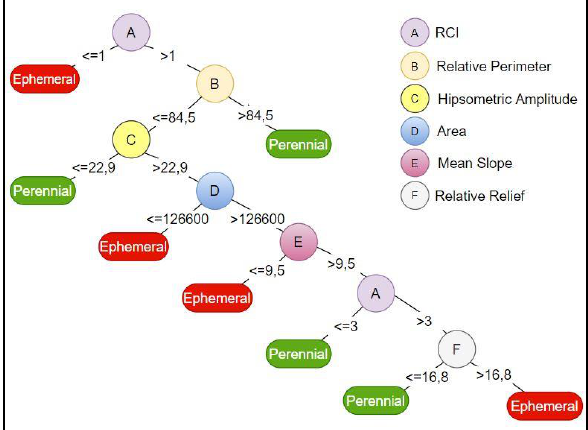
Figure 4: Decision tree generated by J48 from the sample